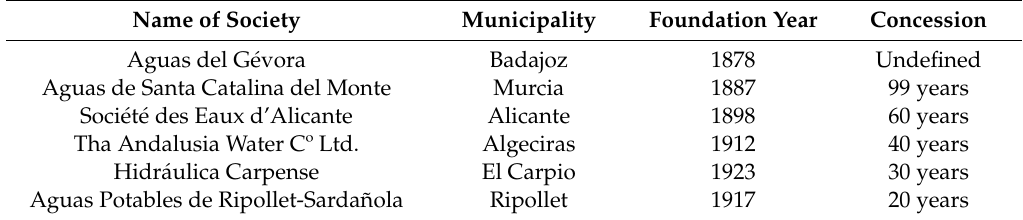
Table 5. Examples of di ff erent concession periods granted to water